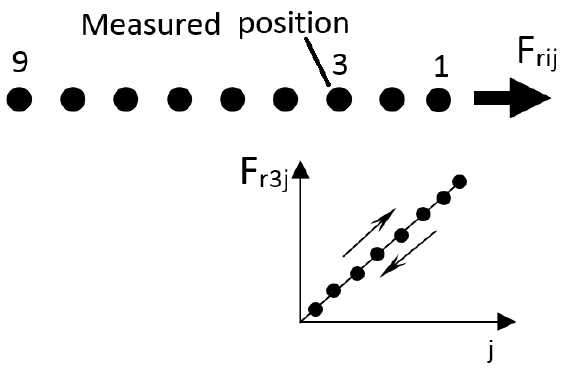
Figure 2. The first measurement scenario scheme. F rij —Force in the “r” direction, applied in the “i” position, with the load “j”. F r3j —Force in third position, applied and relieved. Figures 3 and 4a,b show real experiment layout. The load in the X axis direction will be applied to the table by a rope mechanism.